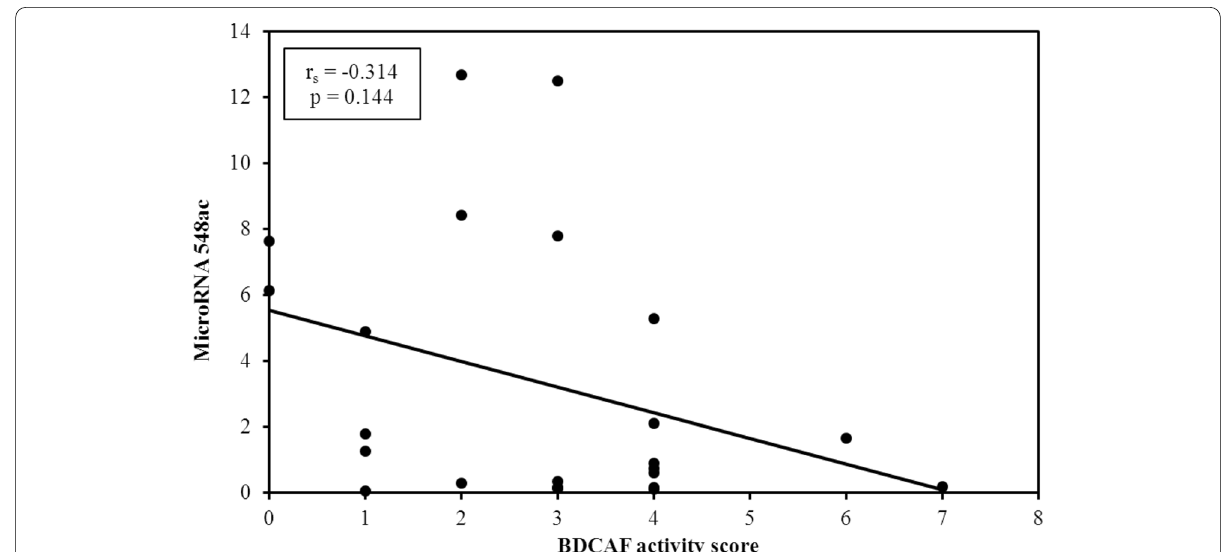
MiRNA548ac was negatively correlated to BDCAF activity score in patients but non-significantly, with rs 0.314, p 0.144, Fig . 1. − = There was significant positive correlation between miRNA548ac expression in the patients and their history of good treatment response, with rs Fig. 2.